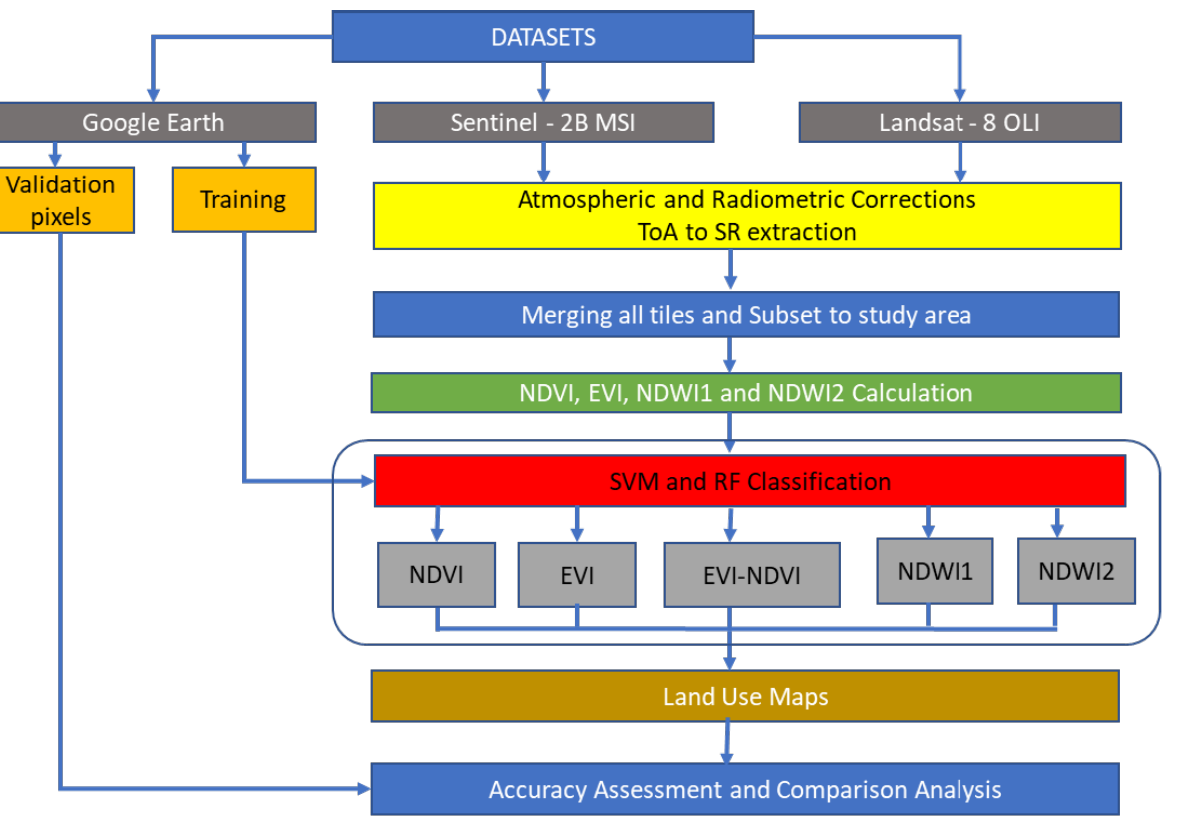
Figure 3. Methodology applied for this research.